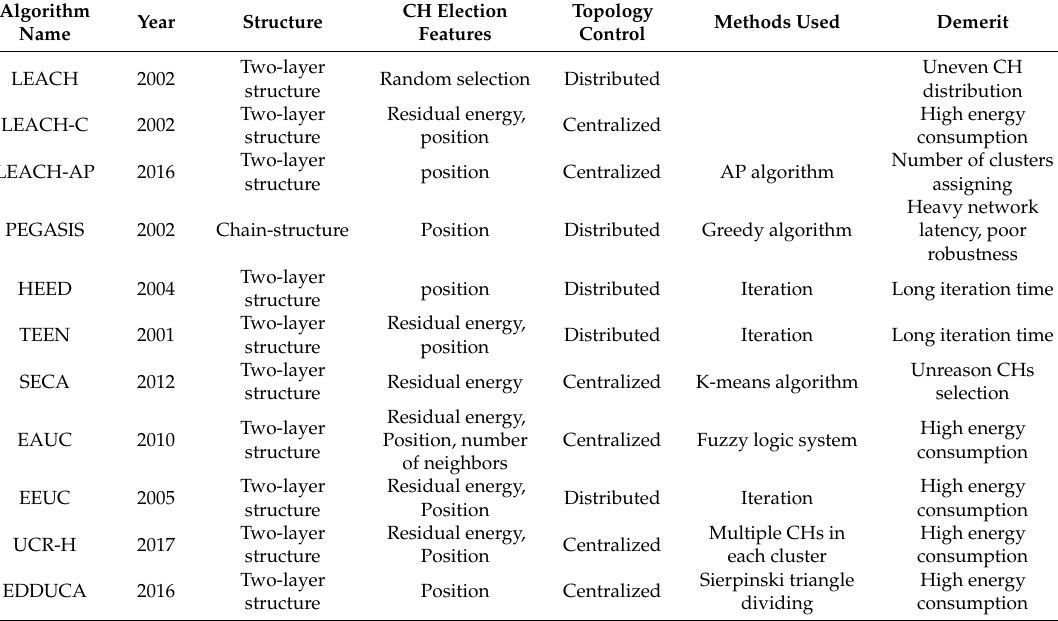
Table 1. Comparison of routing protocols based on